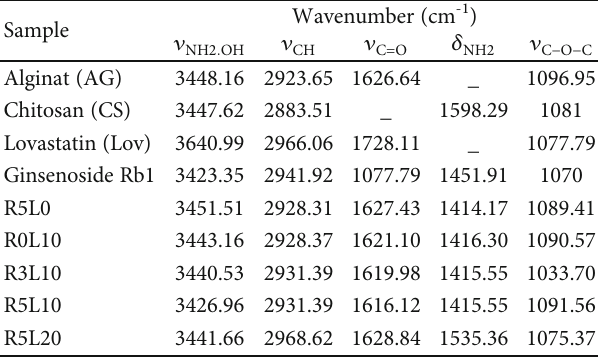
Table 3: IR band for characterized groups of AG, CS, Lov, ginsenoside Rb1, and NPB with di ff erent Lov